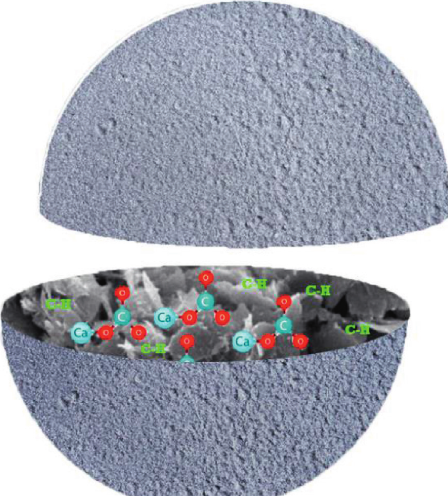
Figure 11: Concrete microstructure model with respect to CaCO3 formation during accelerated CO2 exposure in two different kinds of cement: (a) OPC and (b) high-volume GGBS cement.